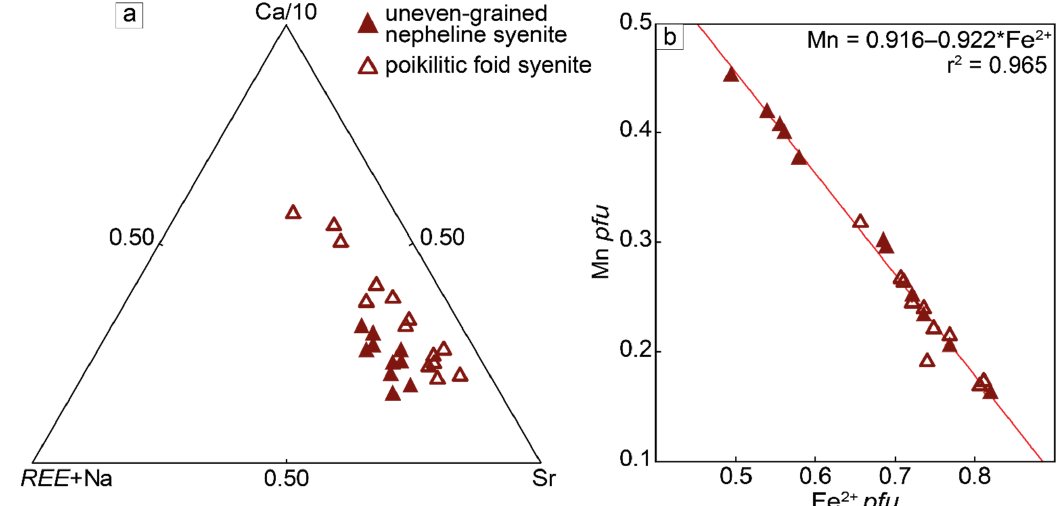
Figure 13. ( a ) Ca–(REE+Na)–Sr systematic of fluorapatite from poikilitic rocks. Fluorapatite from uneven-grained nepheline syenite is enriched in REE and Na. ( b ) Binary diagram showing the Fe concentration in ilmenite from poikilitic rocks as a function of Mn content.